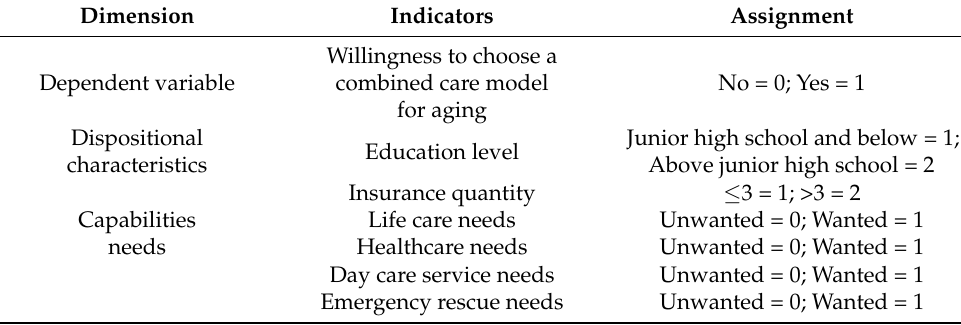
Table 4. Multivariate logistic regression analysis of factors influencing the elderly’s willingness to select the combined medical care and nursing care